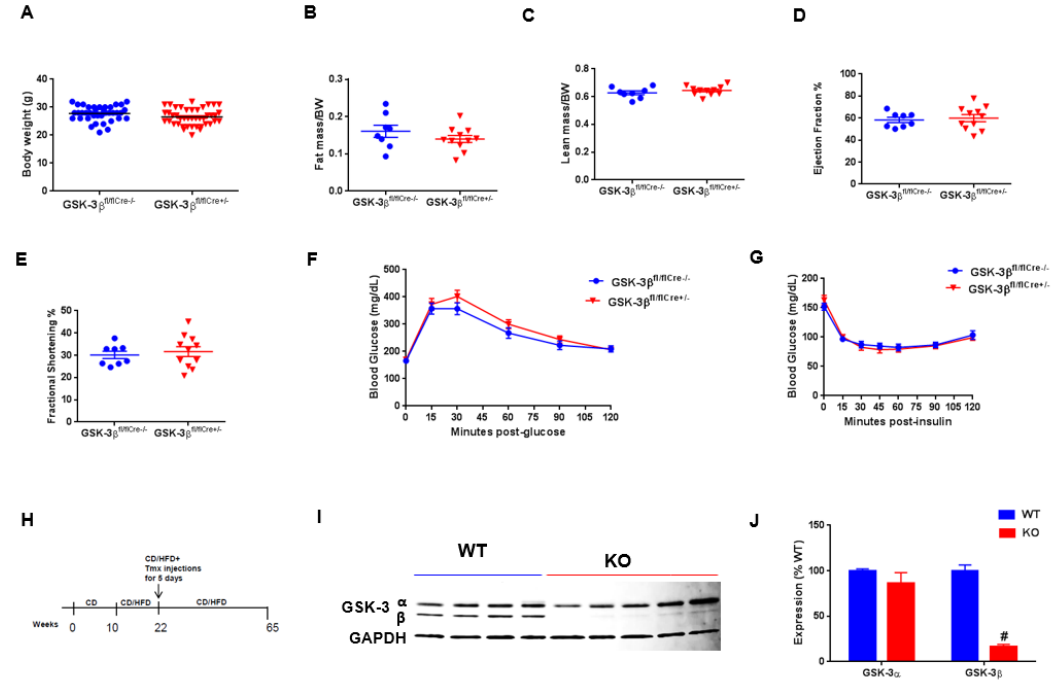
Figure 1. Characterization of cardiomyocyte (CM)-specific inducible Glycogen Synthase Kinase-3 beta (GSK-3 β ) KO mouse model. ( A ) Baseline body weights, ( B ) fat mass, ( C ) lean mass, ( D ) left ventricular